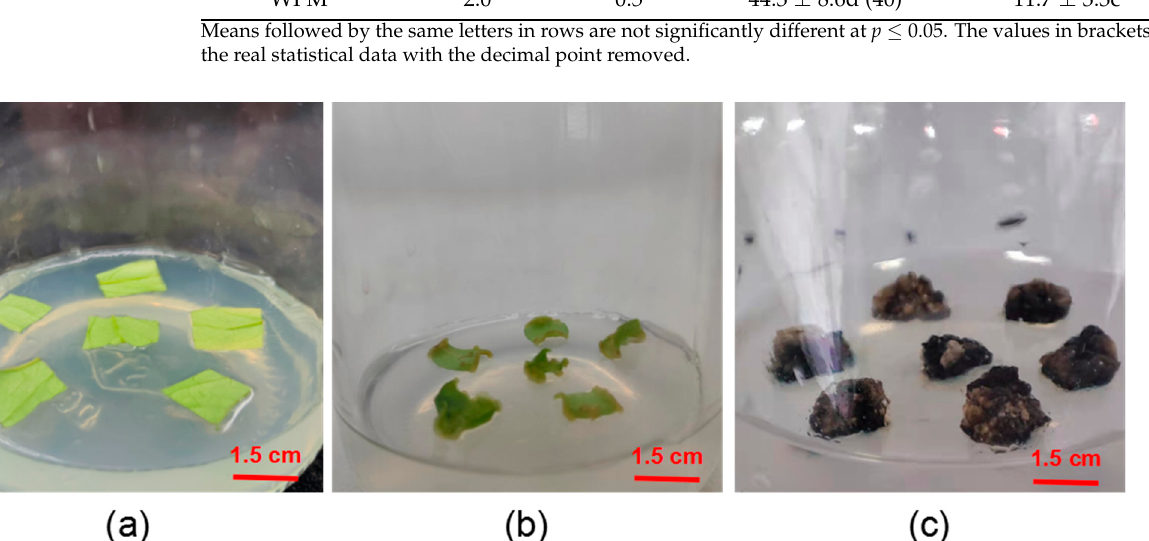
Table 3. Effect of different plant growth regulators and media on callus induction in D. lotus leaf discs.